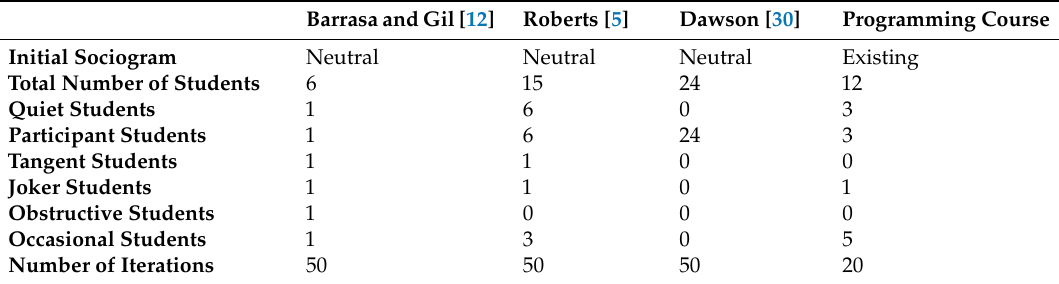
Table 2. Input parameters of the simulator for the different